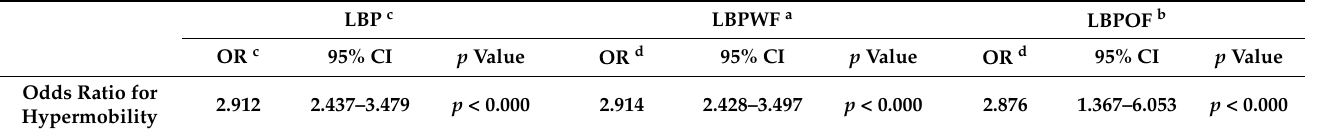
Table 2. Odds Ratios for Low Back Pain in Relationship to Symptomatic Joints